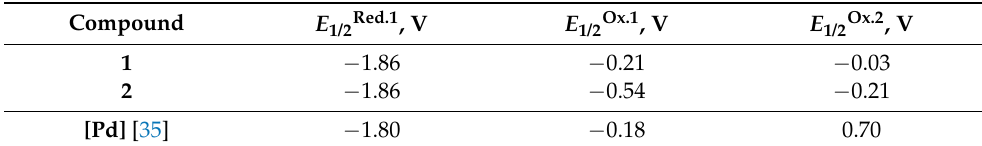
Table 2. The CV data for 1 and 2 and a comparison with the literature data (potentials are given vs. Fc/Fc + redox